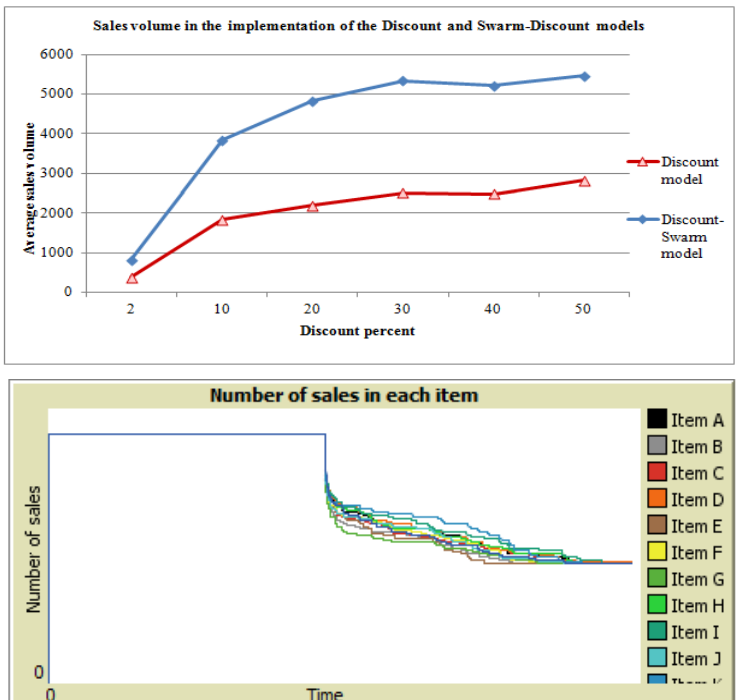
Fig. 10. Customers' IB behavior and calculating sales volume in discount and swarm -discount model in different discount